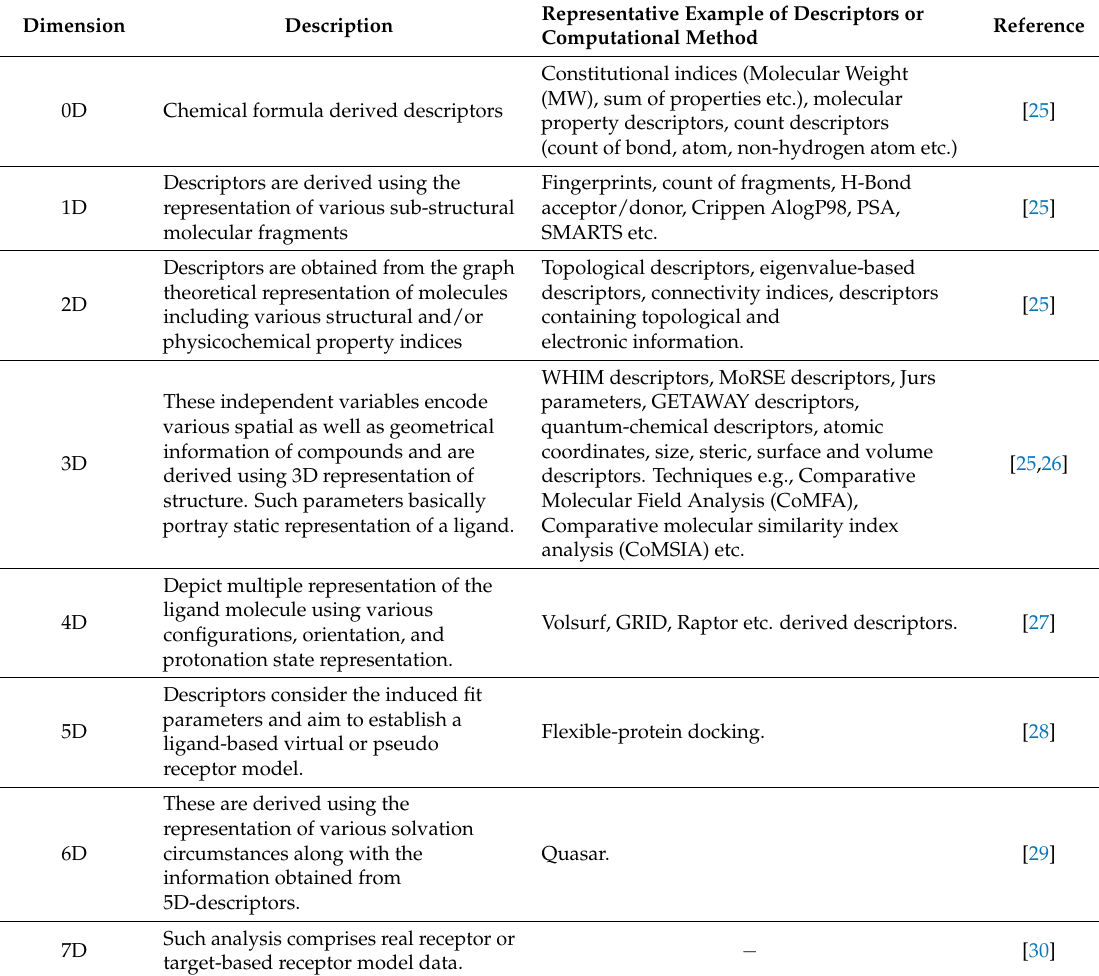
Table 1. Classification of quantitative structure-activity relationship (QSAR) analysis based on dimension.